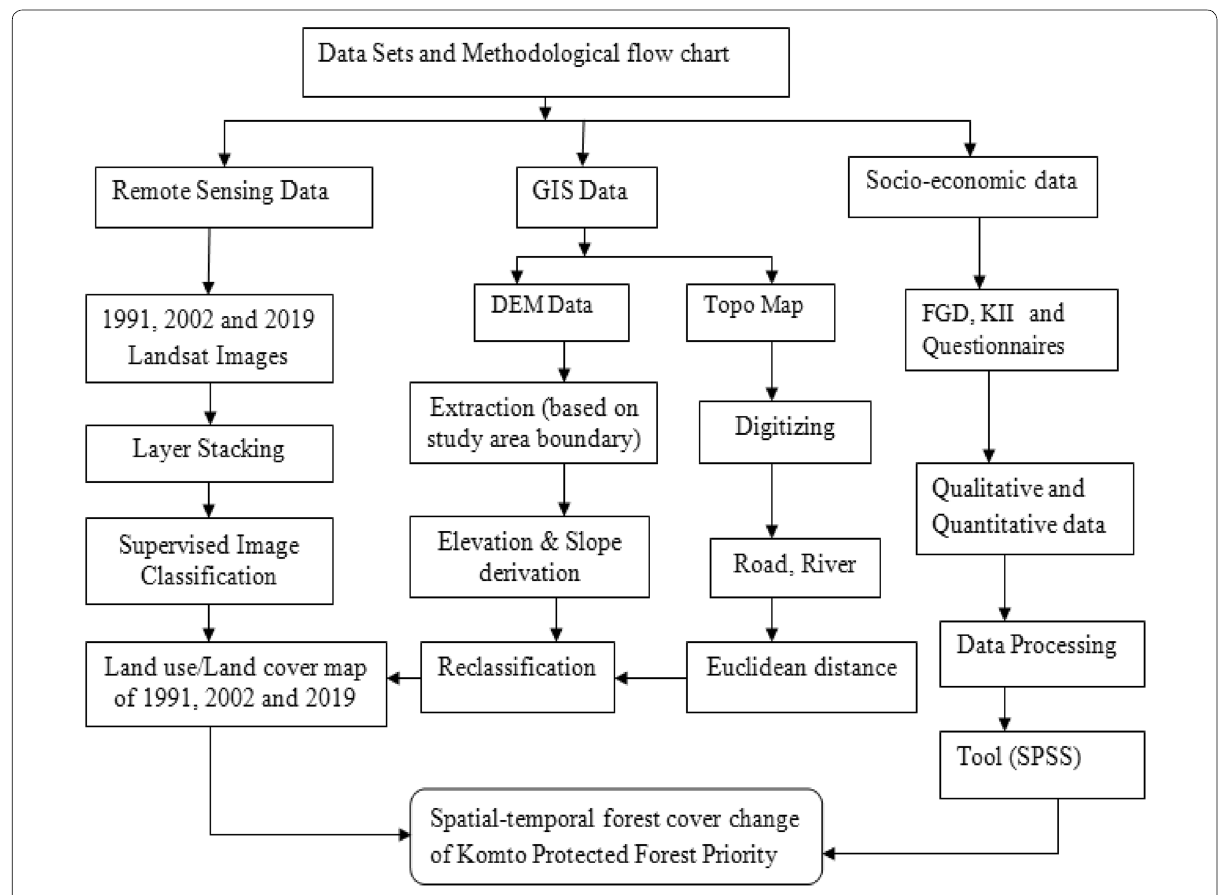
Fig. 2 Methodological flow chart